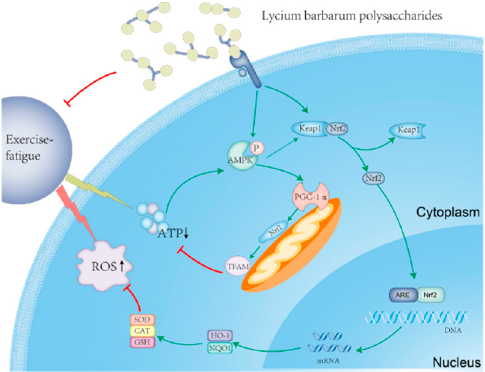
Figure 13. Anti-fatigue effect of LBP via the Nrf2 and PGC-1 α signaling pathways in rats. Supplementary Materials: The supporting information can be downloaded at: